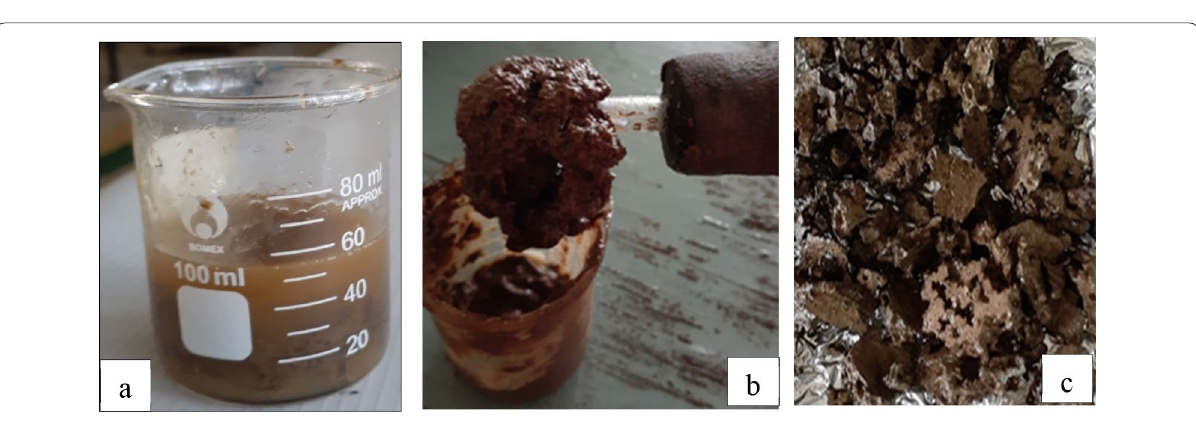
Fig. 4 Pyrolysis products ( a ), b Bio-crude oil, c